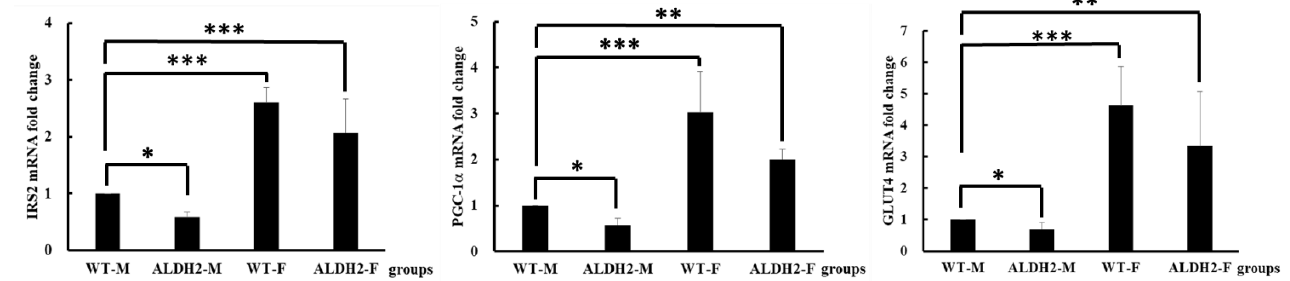
Figure 3. Gene-expression levels in liver tissue samples of wild-type and ALDH2 knock-in mice fed 60% high-fat diet. Data presented as mean ± standard deviation (SD). * p < 0.05, ** p < 0.01, *** p < 0.001 compared with WT-M.